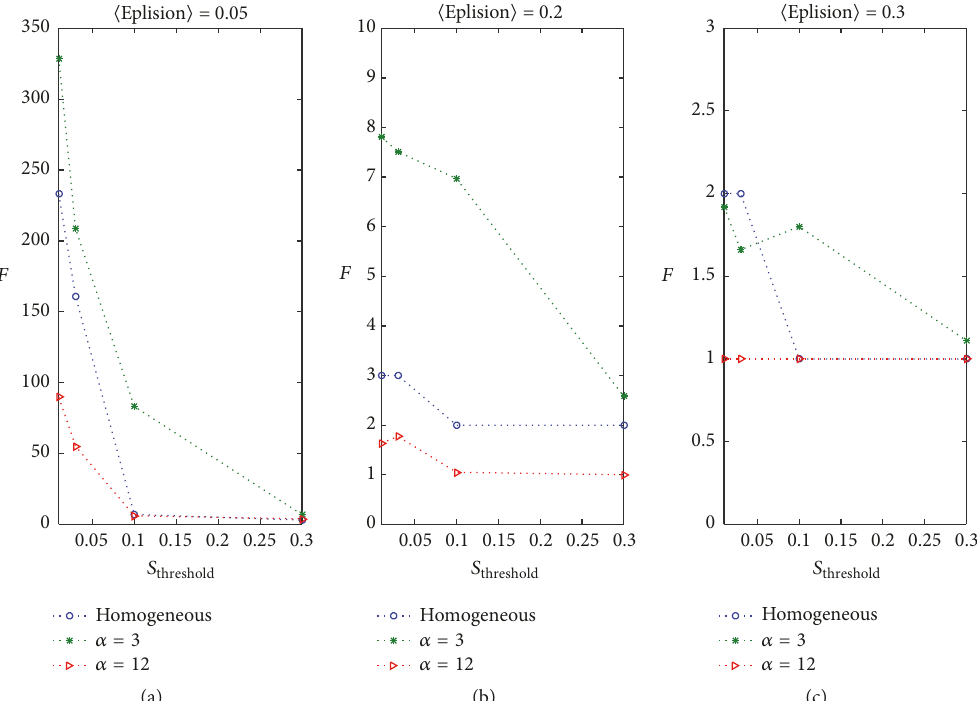
Figure 10: Comparison of 𝐹 (opinion cluster number) on the heterogeneous SSHK model and homogeneous SSHK model with no correlation between the confidence bound and social similarity threshold. Every result is averaged 100